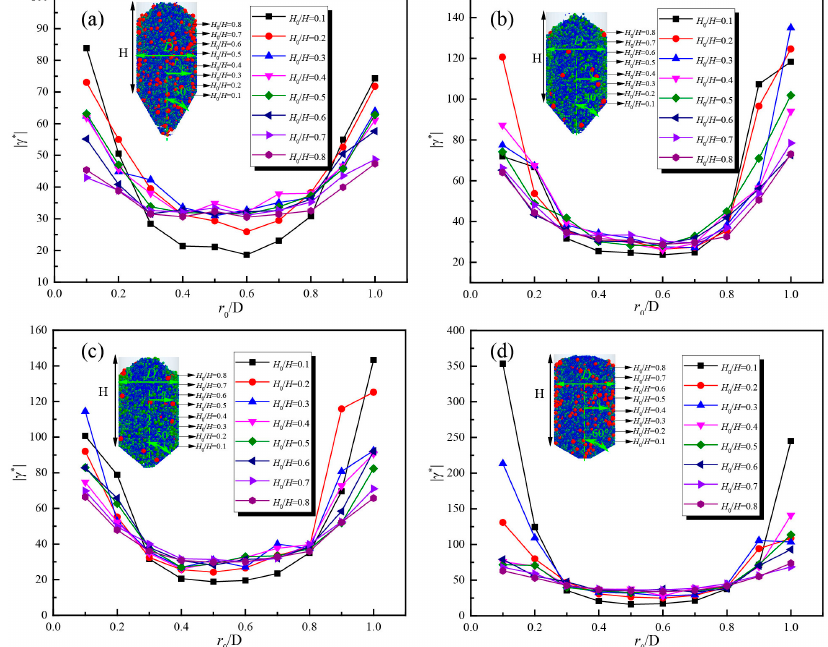
Figure 21. The variation in the shear rate of sinter layers with variations in the half hopper angles of ( a ) 30°, ( b ) 40°, ( c ) 50°, and ( d )